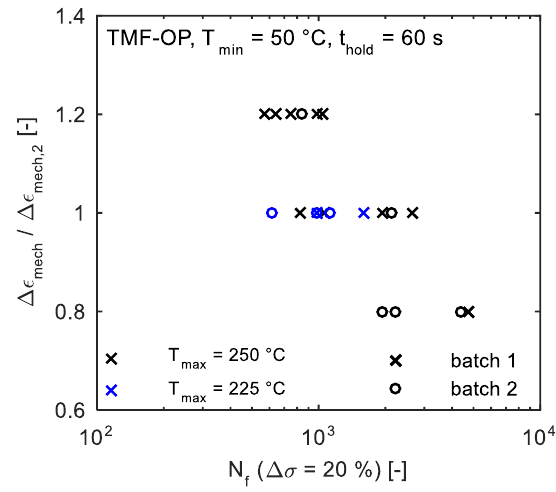
Figure 5. Relation between mechanical strain range (scaled) and lifetime for all TMF tests performed.